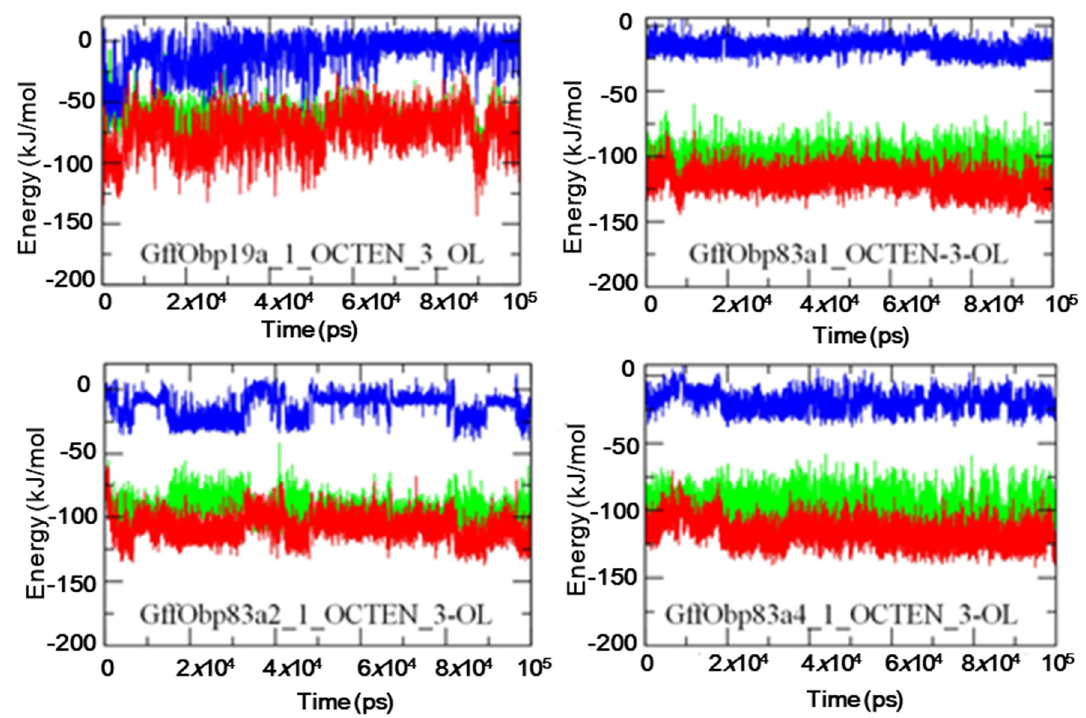
Figure 6. The Molecular Mechanics Poisson–Boltzmann Surface Area (MM-PBSA)-based calculated energy curves showing the variations in the interaction energies observed between the proteins and docked ligands during 100 ns molecular dynamics (MD) simulations. (light green, Vander Waals energy; blue, electrostatic energy; red, total energy).